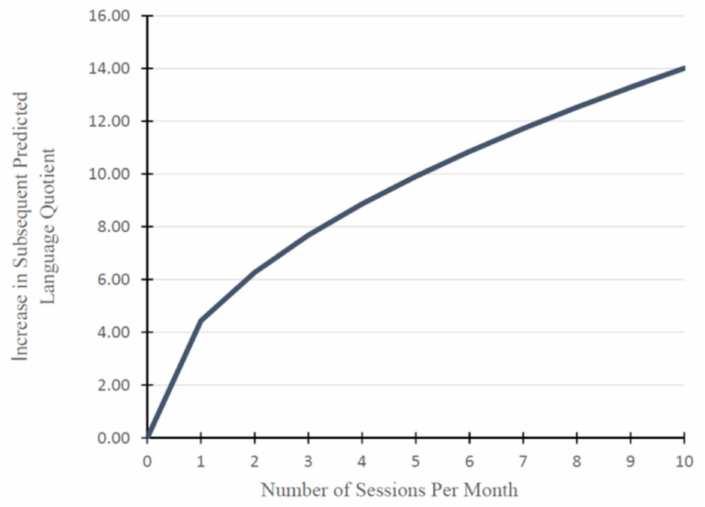
Figure 2. Increase in language quotient by the number of sessions reported per